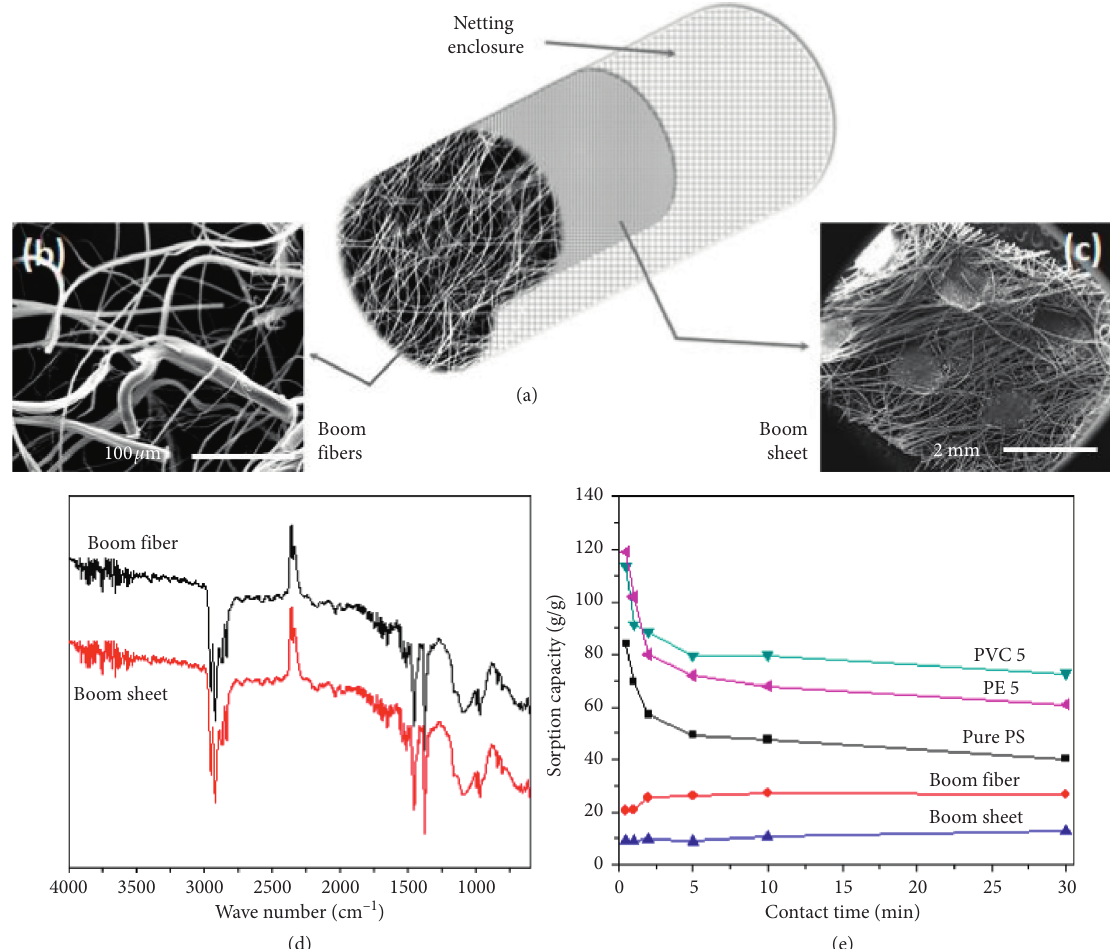
Figure 8: (a) A schematic structure of a typical fibrous boom. SEM micrographs of the internal boom fibers (b) and the boom sheet (c), (d) infrared spectra of the commercial boom fibrous sorbent and its sheet, and (e) uptake capacity of a commercially available polypropylene boom fibrous sorbent and its sheet as compared with that of pure polystyrene and blends of polystyrene with 5wt.% of each of PE and